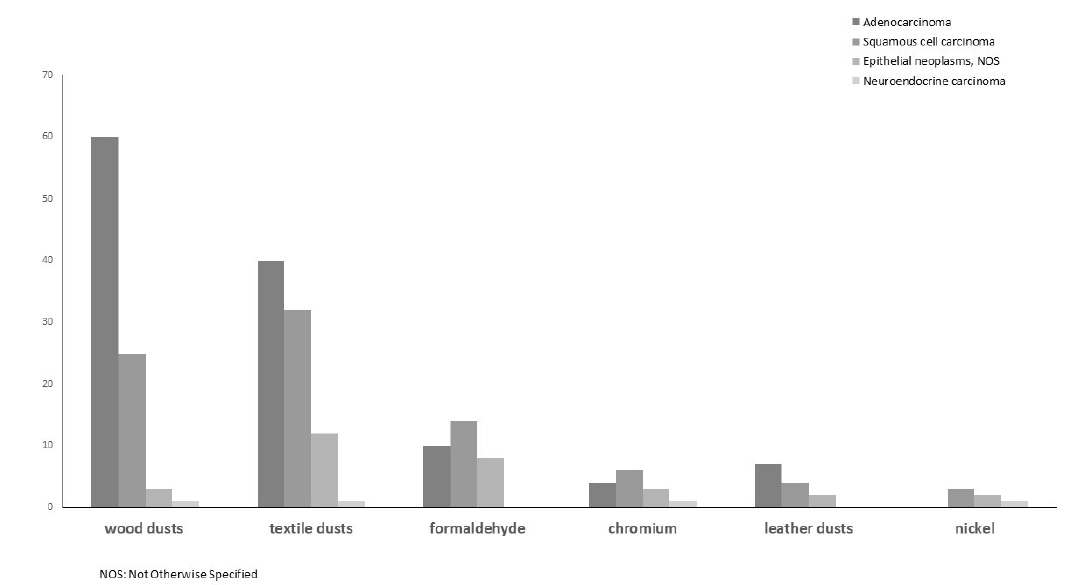
Figure 1. Distribution of SNC morphology (%) by exposures to IARC carcinogenic agents for nasal cavities and paranasal sinuses.